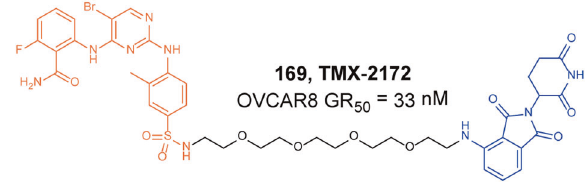
Fig. 44 The representative PROTAC targeting CDK2/5